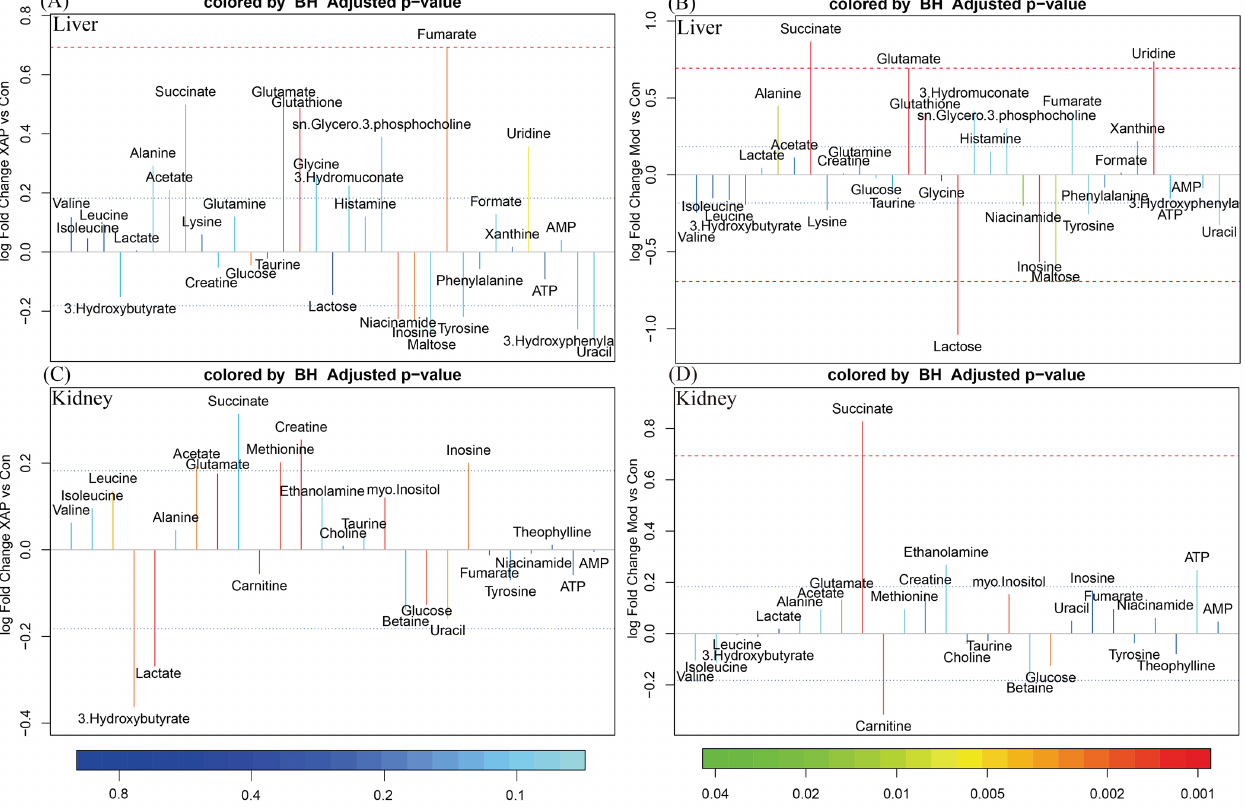
FIGURE 2 - Typical 500 MHz 1 H NMR spectra of liver tissue and kidney extracts obtained from Con. (black lines), MTE (XAP) (green lines) and Mod groups (red lines). The metabolites are labeled as follows: 1. Valine, 2. Isoleucine, 3. Leucine, 4. 3-Hydroxybutyrate, 5. Lactate, 6. Alanine, 7. Acetate, 8. Succinate, 9. Lysine, 10. Creatine, 11. Glutamine, 12. Glucose, 13. Taurine, 14. Glutamate, 15. Glutathione, 16. Glycine, 17. Lactose, 18. 3-Hydromuconate, 19. Histamine, 20.